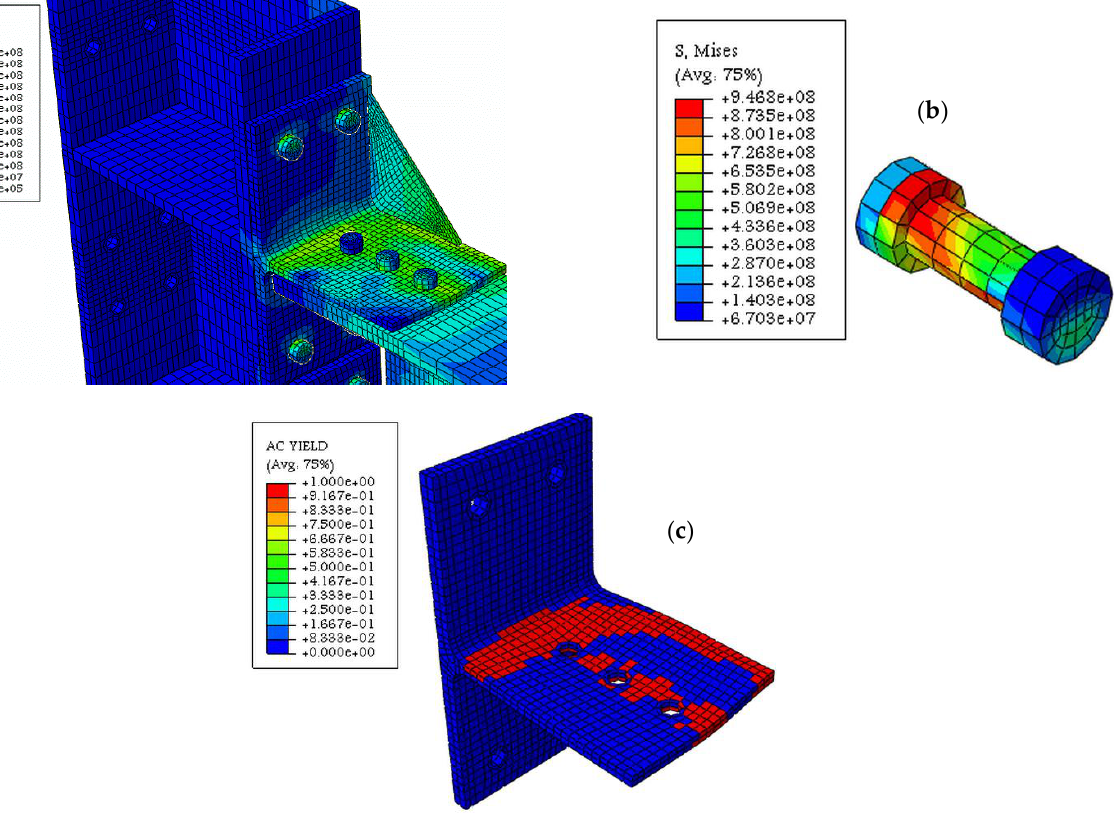
Figure 9. Stress concentration on SP18 model. ( a ) General view, ( b ) bolt, and ( c ) T-stub under cyclic loading.